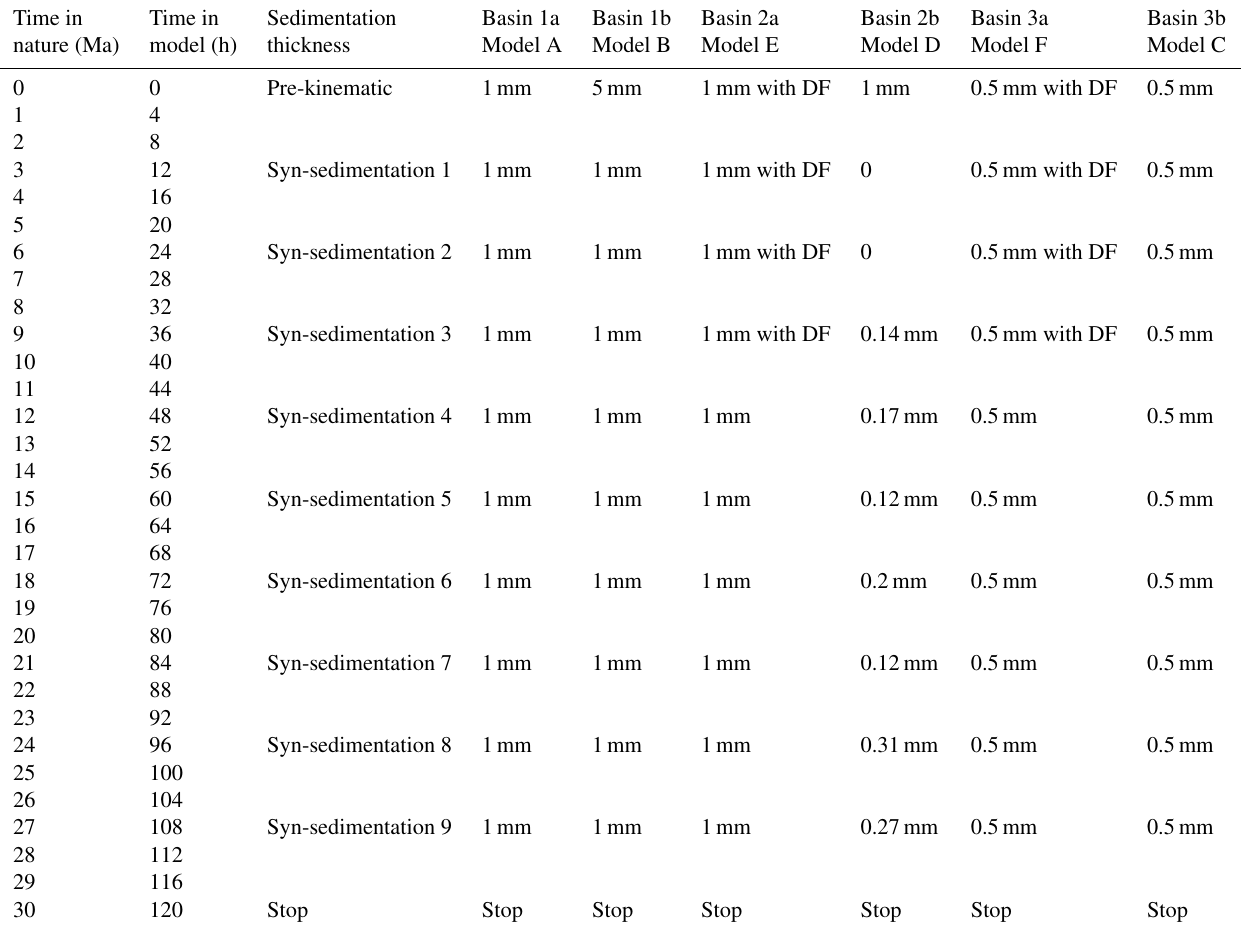
Table A1. Sedimentation rates, pre- and syn-kinematic depositional scenarios for all six silicone basins of the three experiments. Note the labels of basins, such as Basin 1a and 1b, are for paired models. The labels of models are the names referred to in the main text. Time